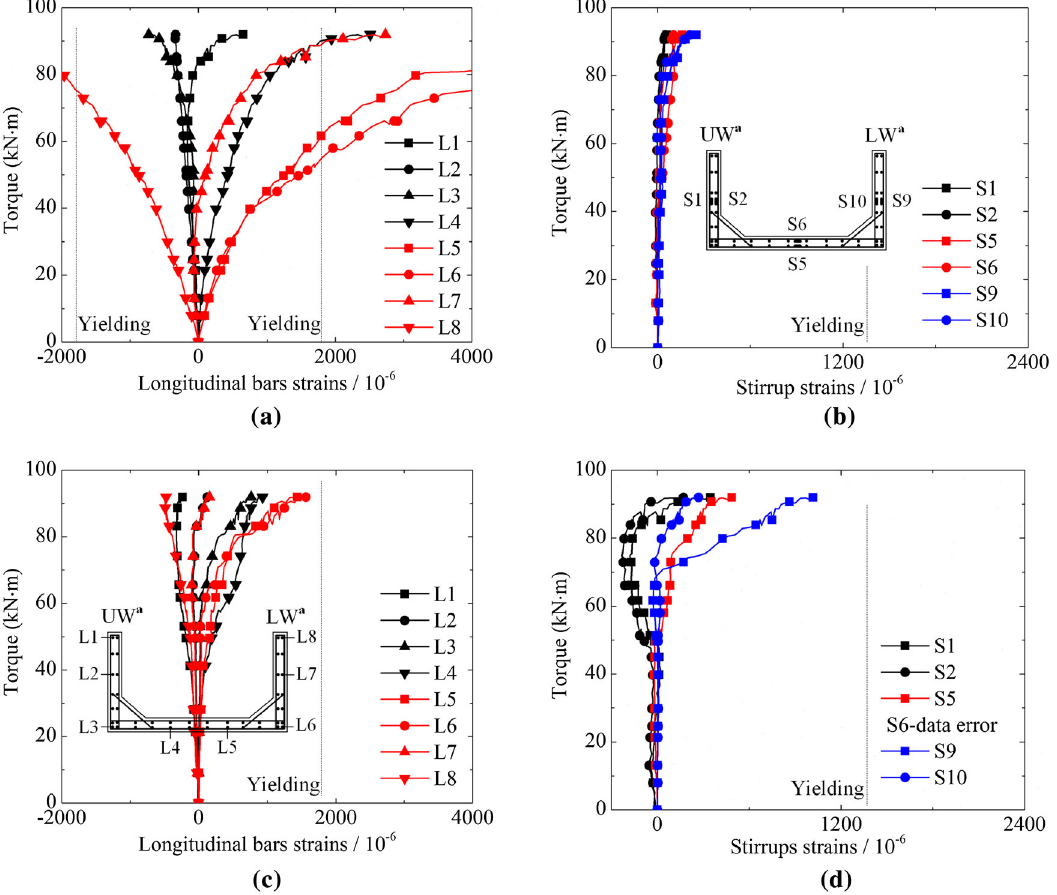
Fig. 10 Reinforcement strains of MEM-1:1. a Longitudinal bars strains at mid-span, b stirrup strains at mid-span, c longitudinal bars strains at quarter span, and d stirrup strains at quarter span. a The ‘‘LW’’ and ‘‘UW’’ mean ‘‘Loaded Web’’ and ‘‘Unloaded Web,’’